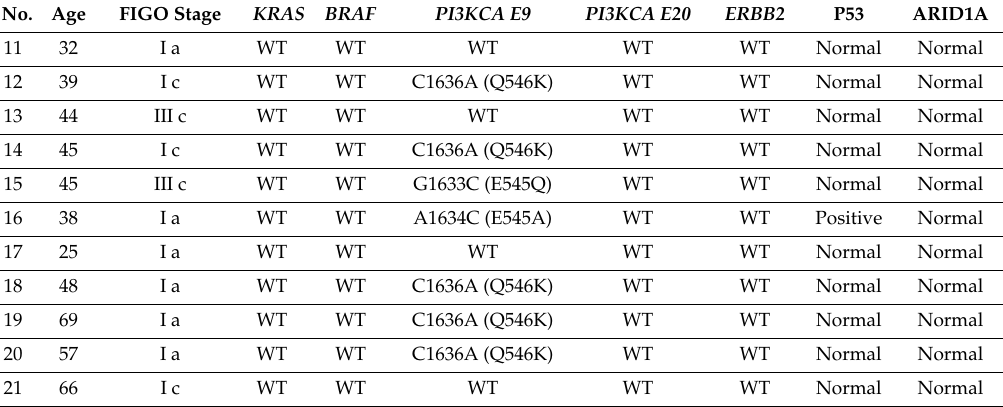
Table 2. Mutation and immunohistochemical analysis of serous borderline tumor (SBT). WT; Wild Type. No. Age